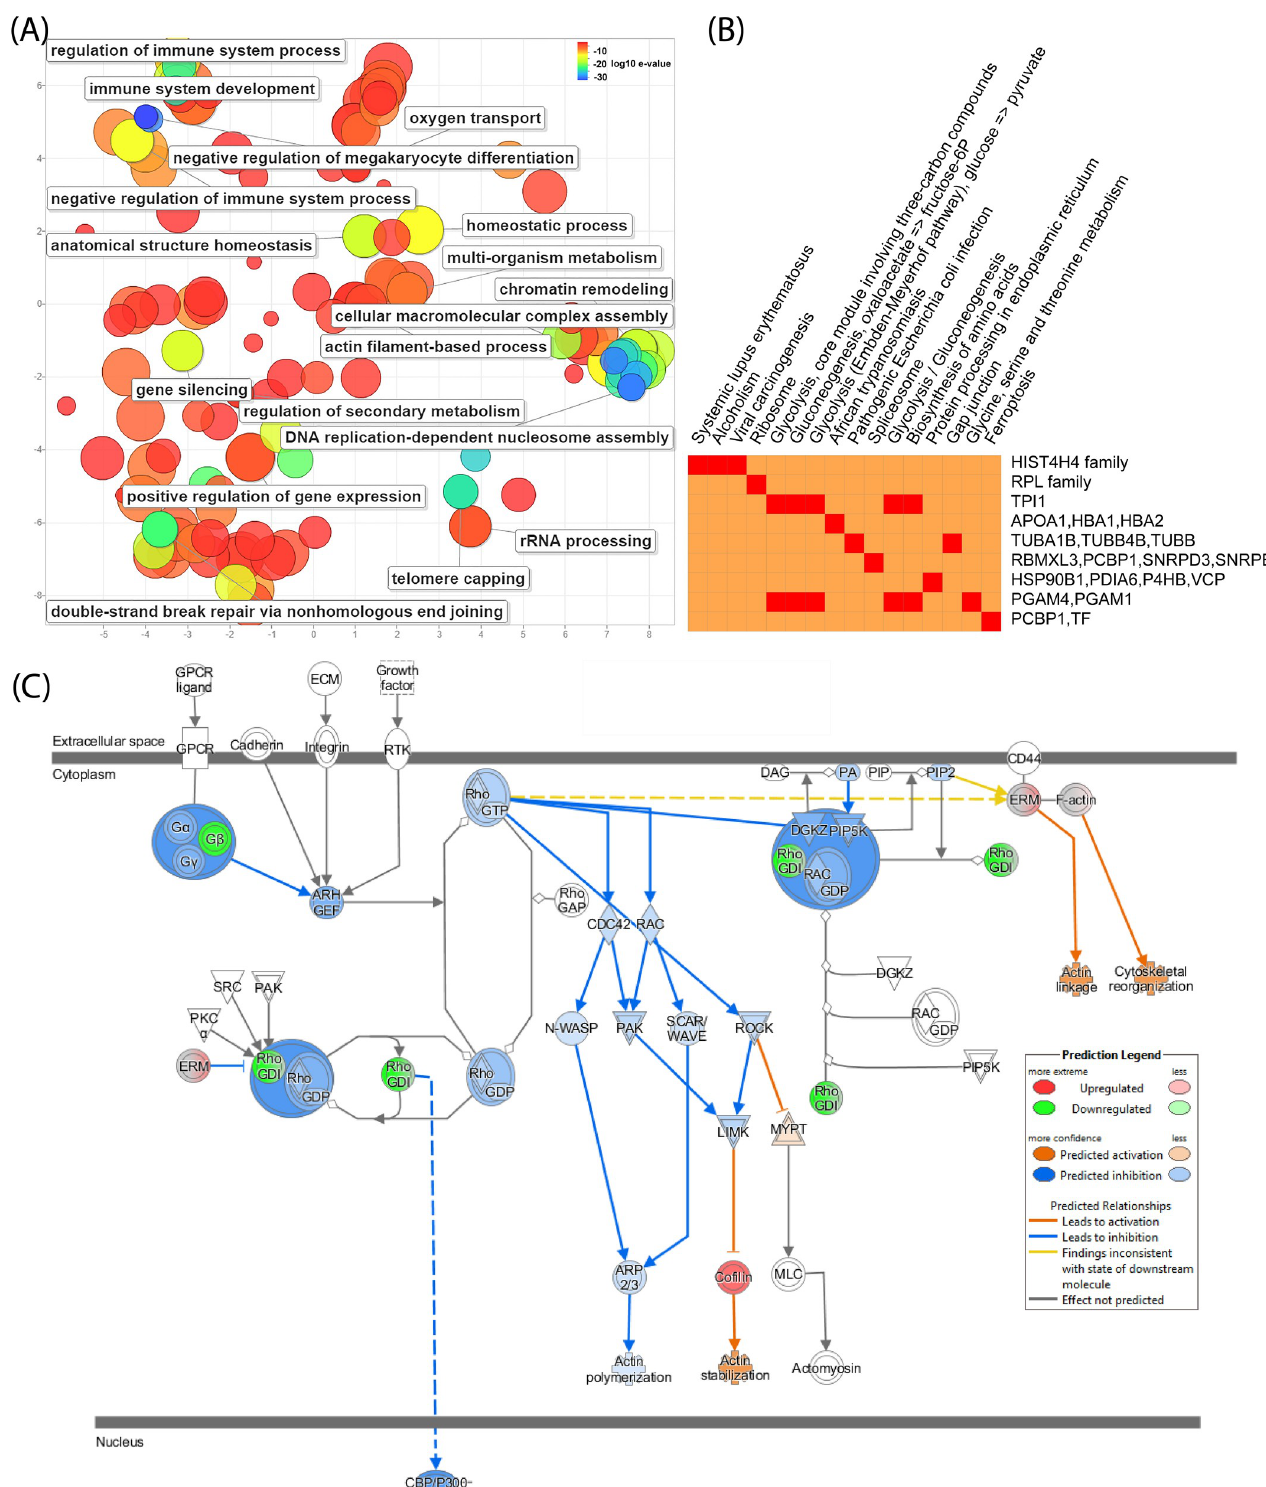
Fig 3. The significant biological processes and KEGG pathways identified from significantly upregulated proteins with LPS treatment. RhoGDI family signalling pathway was predicted by IPA as the canonical pathway with the highest predicted potential/significance. (A) The significant biological processes with corrected P-values < 10 − 6 ; (B) The KEGG pathways with corrected P-values < 0.05 and (C) The up-/down-regulations of proteins induced by LPS are